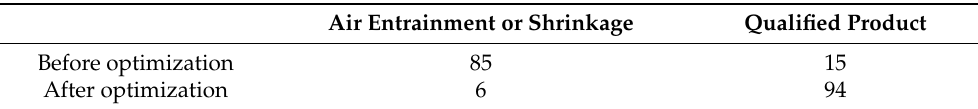
Table 6. X-ray inspection results of 100 castings taken before and after optimization.